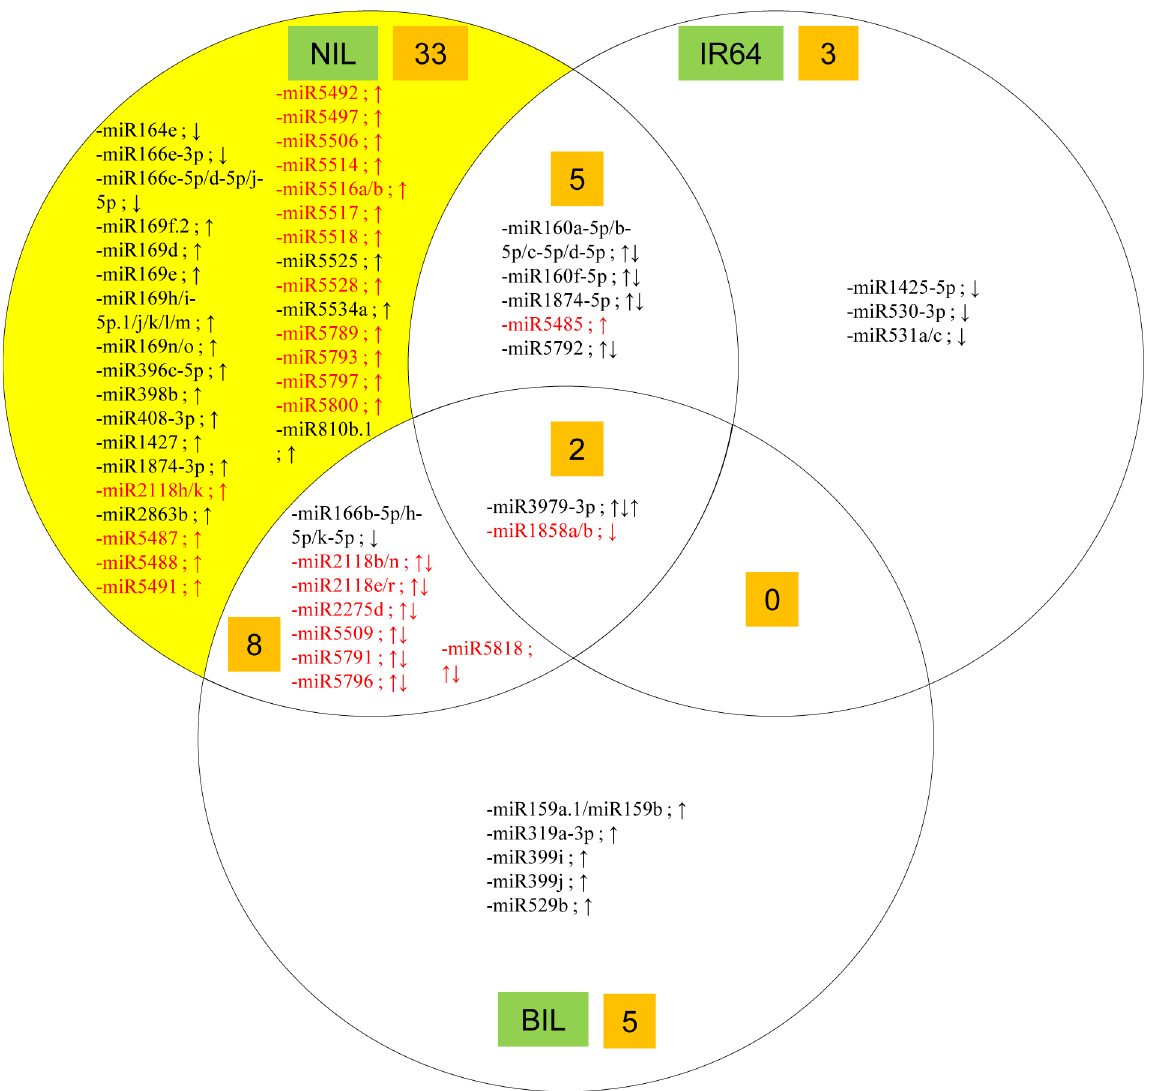
Fig 3. The drought-responsive miRNAs identified in the inflorescence of three rice lines. miRNA names in red are inflorescence-specificnon-conserved miRNAs. Differential expressionis indicatedby arrows in the order of IR87705-7-15-B (NIL), IR64 and IR77298-14-1-2-10